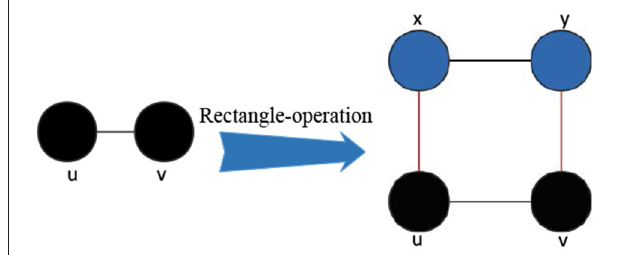
FIGURE 1 | The illustration of graph operation, rectangle operation, where each edge is formed a cycle on right-hand of arrow, where blue vertices represent new